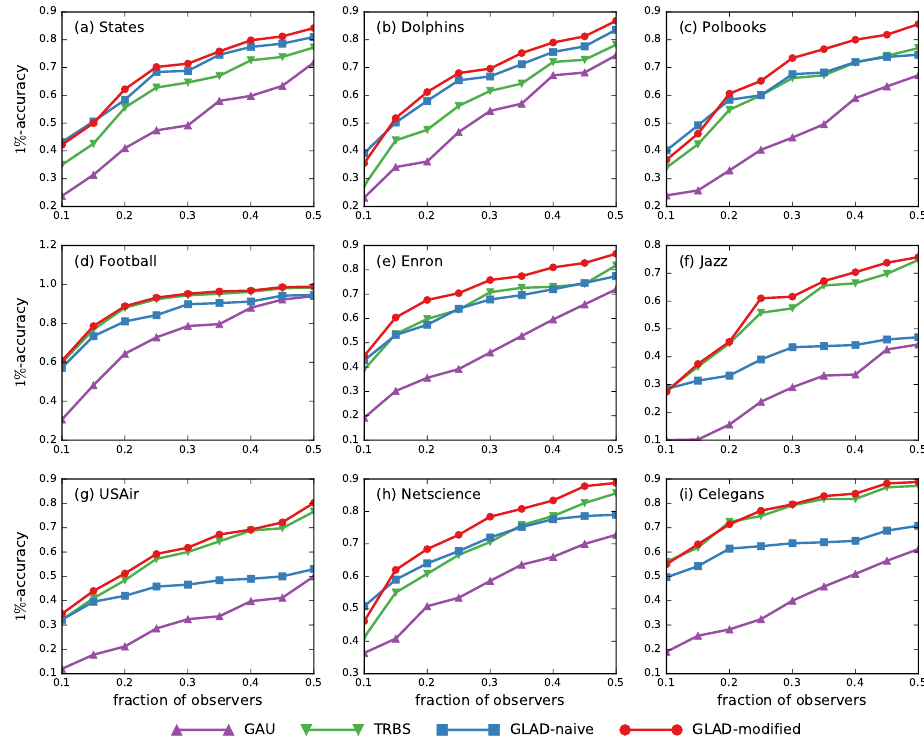
Figure 8. γ %-accuracy of the source localization algorithms on nine real networks with signal-to-noise ratio µ / σ = 4.